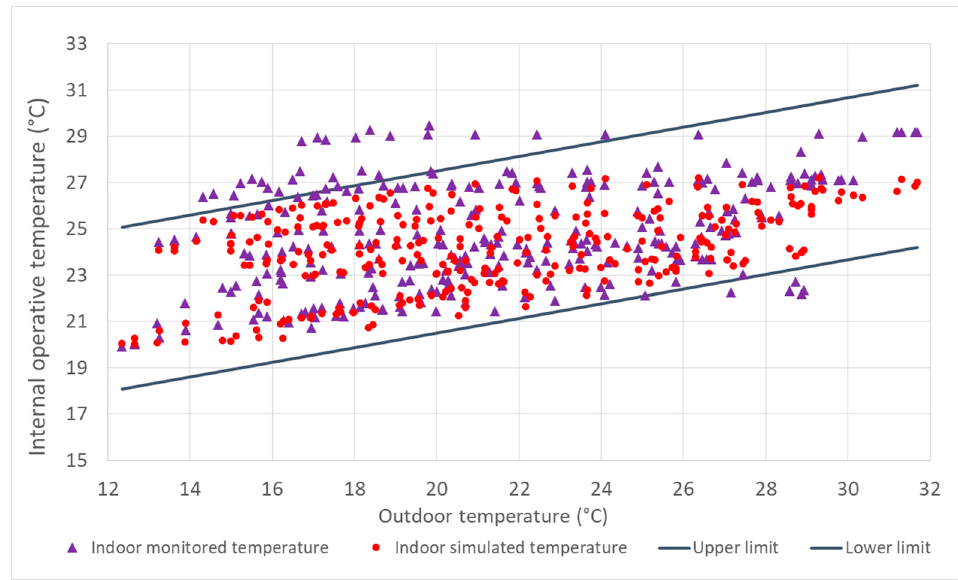
Figure 12. Thermal comfort of the prototype during the summer period according to the ASHRAE 55 Adaptive method [32].